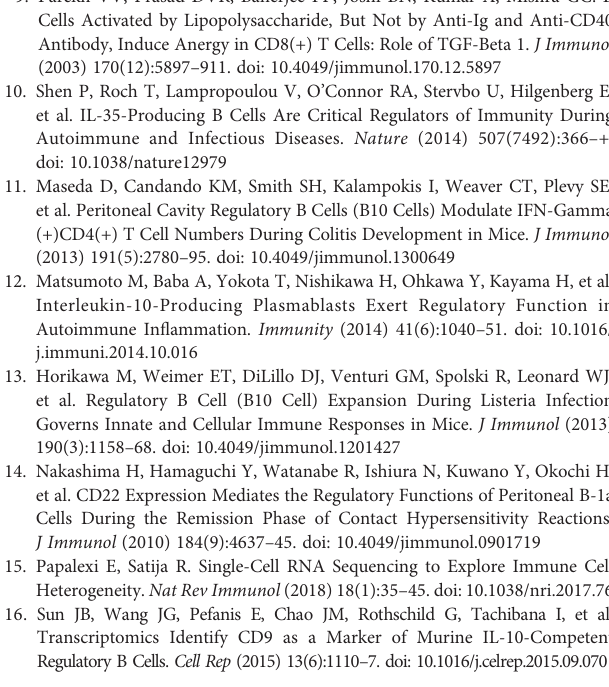
Supplementary Figure 1 | Overview of the study design and data fi lters. (A) The experimental fl owchart of this study. (B) Data complexity of different organs. (C) Gene number (left) and UMI number (right) of different amount of BCR chains. (D) Number of genes (top) and proportion of mitochondrial gene counts (bottom) in different organs after data fi ltering. (E) Total number of cells in different organs. Supplementary Figure 2 | Expression of Breg cells genes and identi fi ed common Breg cells genes. (A) Gene expression of known Breg cells markers